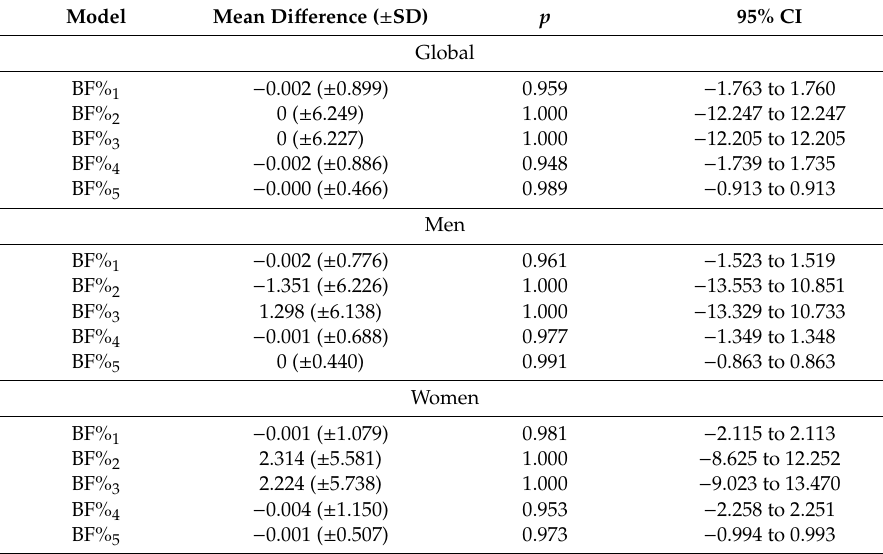
Table 6. Model agreement with CUN-BAE.